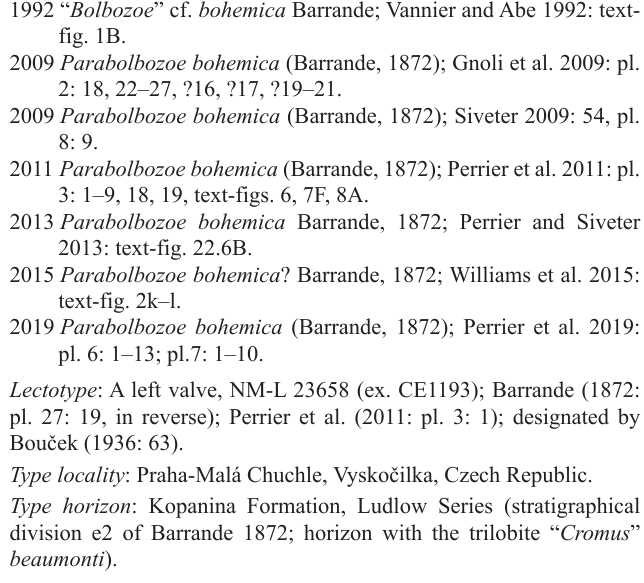
Type locality : Praha-Malá Chuchle, Vysko č ilka, Czech Republic. Type horizon : Kopanina Formation, Ludlow Series